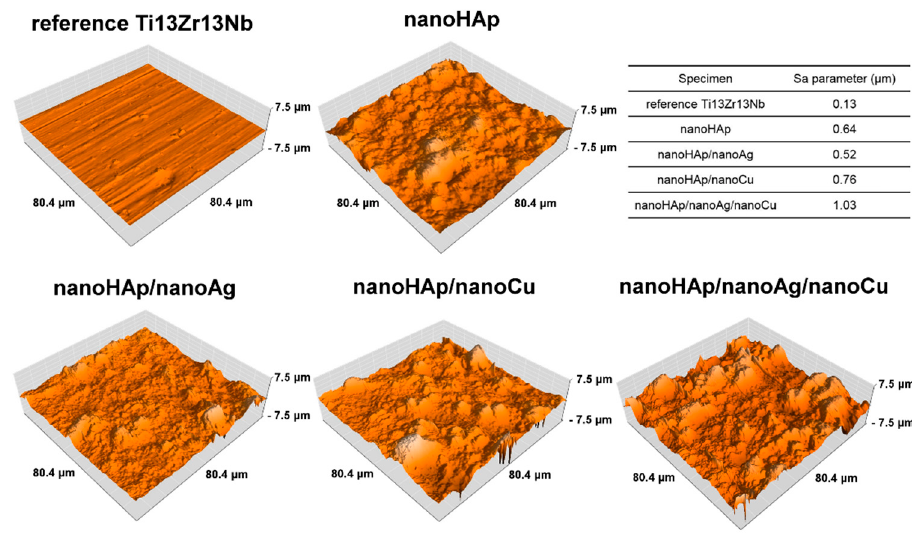
Figure 4. Atomic force microscope (AFM) topography of reference Ti13Zr13Nb alloy and nanoHAp-based coatings.